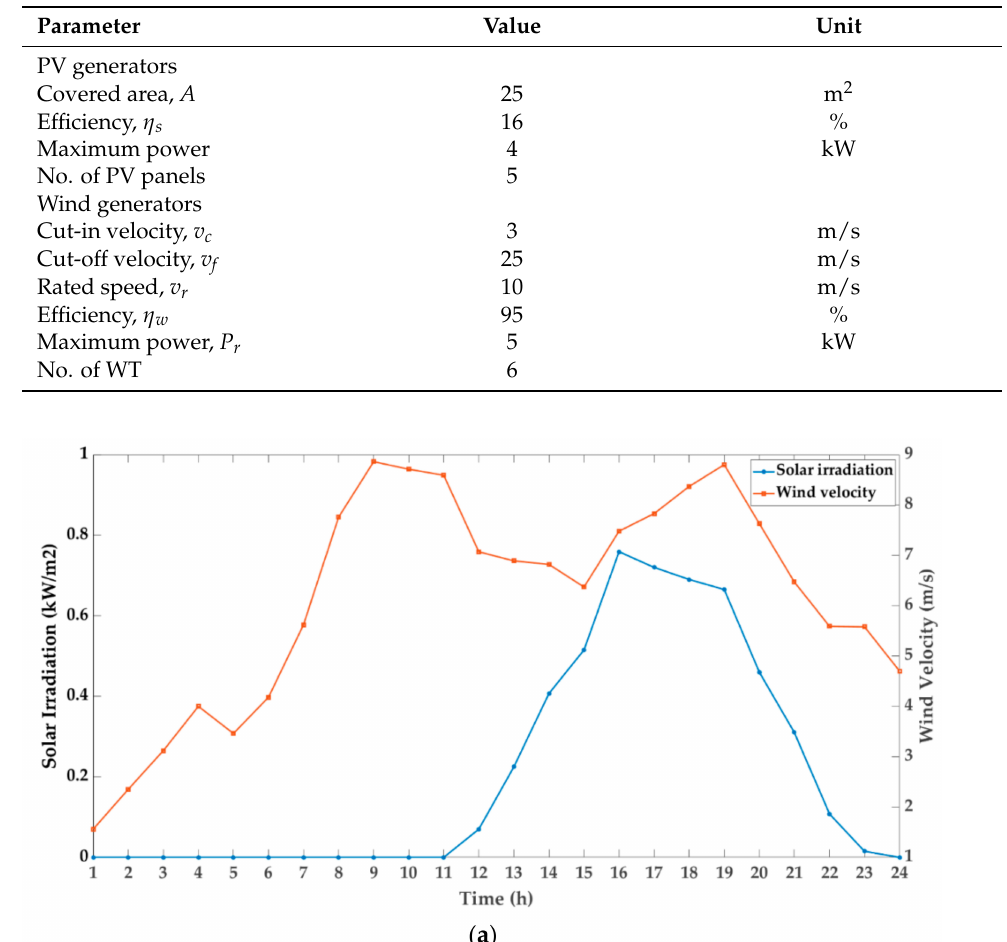
Table 1. Input parameters.